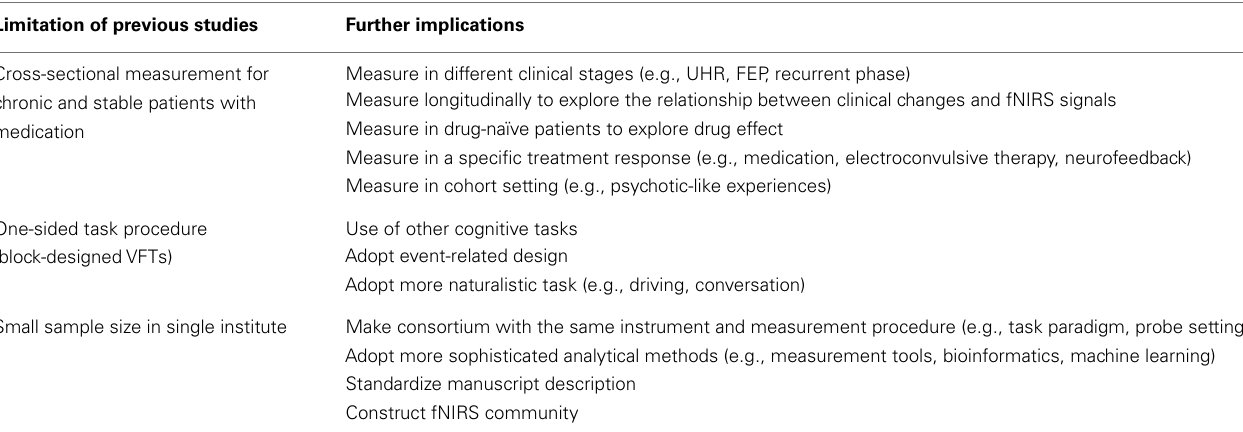
Table 3 | Limitation of previous fNIRS studies and further